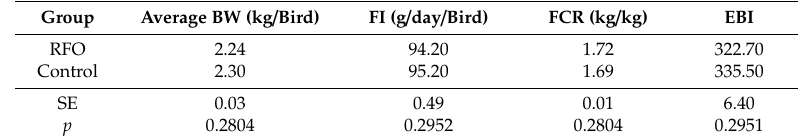
Table 2. Productive performance: mean feed intake, feed conversion ratio, body weight and European Broiler